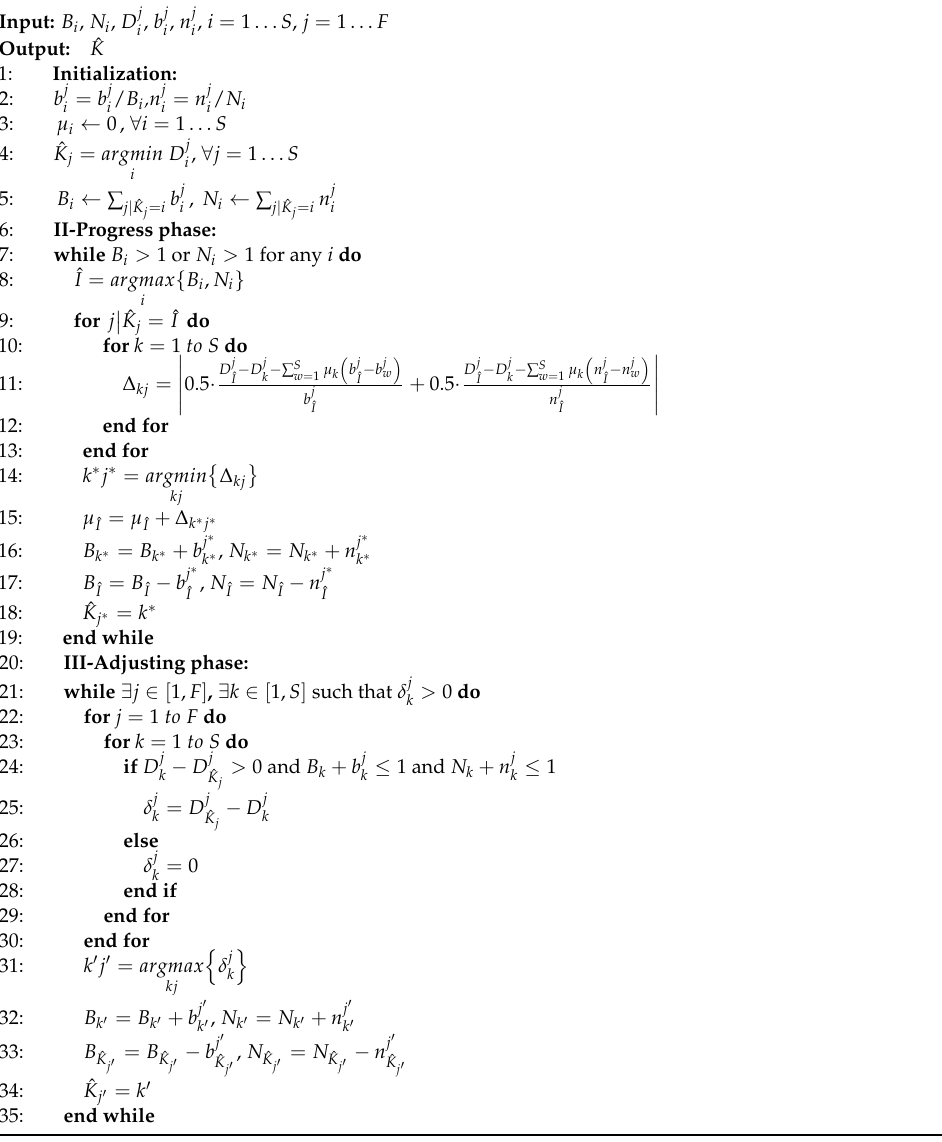
Algorithm 1 Late-binding node selection algorithm for flow